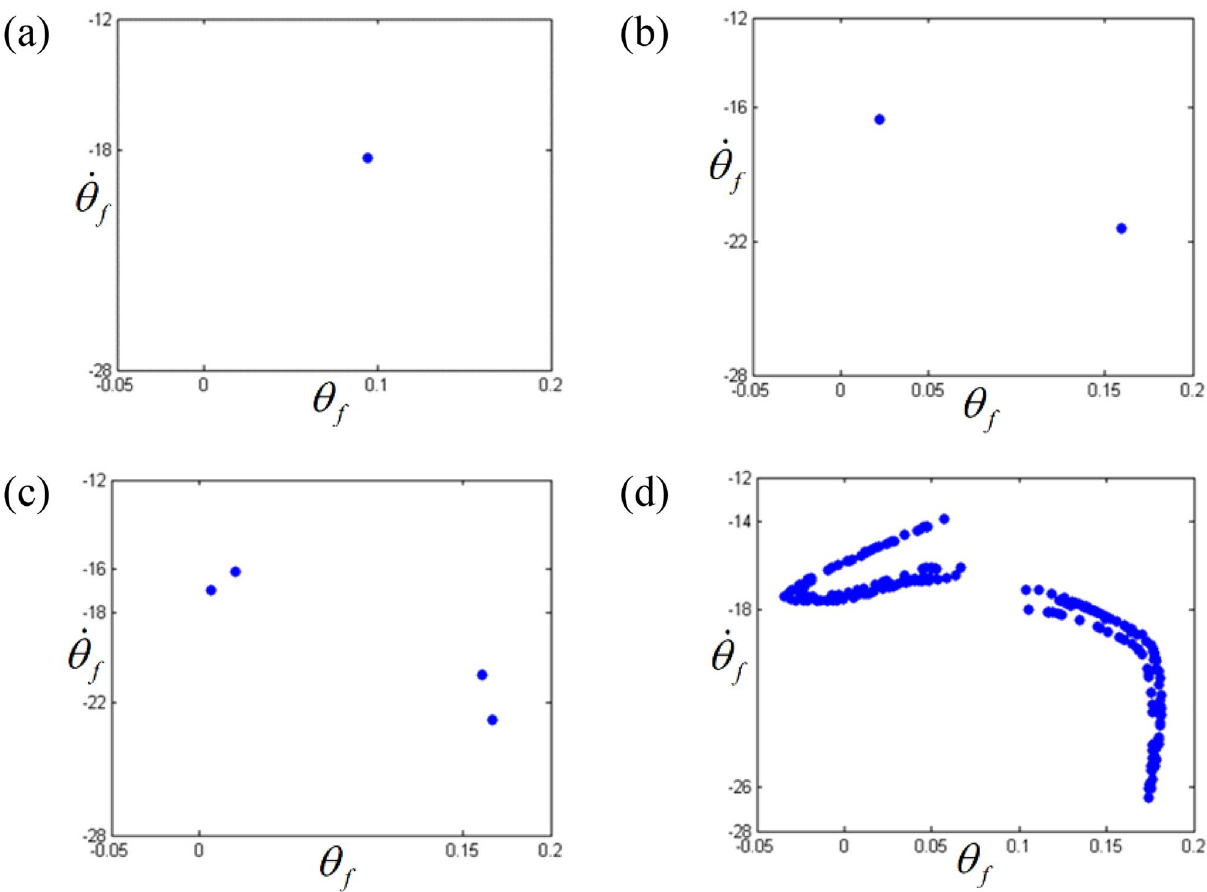
Figure 13. Comparisons of Poincare maps according to different frequency regimes: ( a ) Poincare map at ̟ = 0.98 ; ( b ) Poincare map at ̟ = 0.995 ; ( c ) Poincare map at ̟ = 1.0 ; (d) Poincare map at ̟ = 1.02